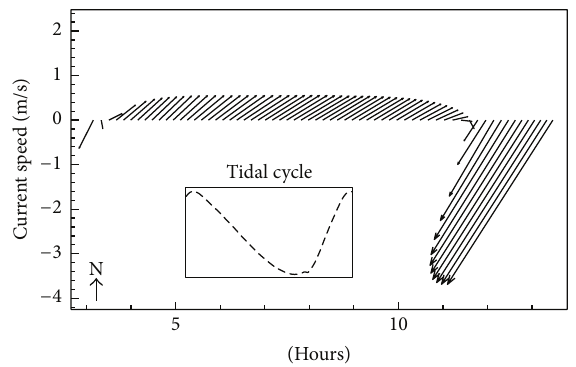
Figure 6: Time series of computed current velocity (top) at Boukhana inlet in a typical tidal period.